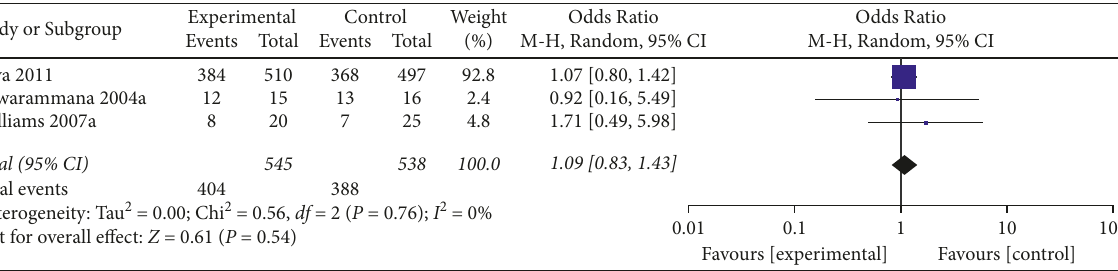
Figure 4: Forest plot of ADRs associated with antivenom use following snakebite between the prehydrocortisone alone groups and the placebo or no premedication groups in three comparisons from three studies.